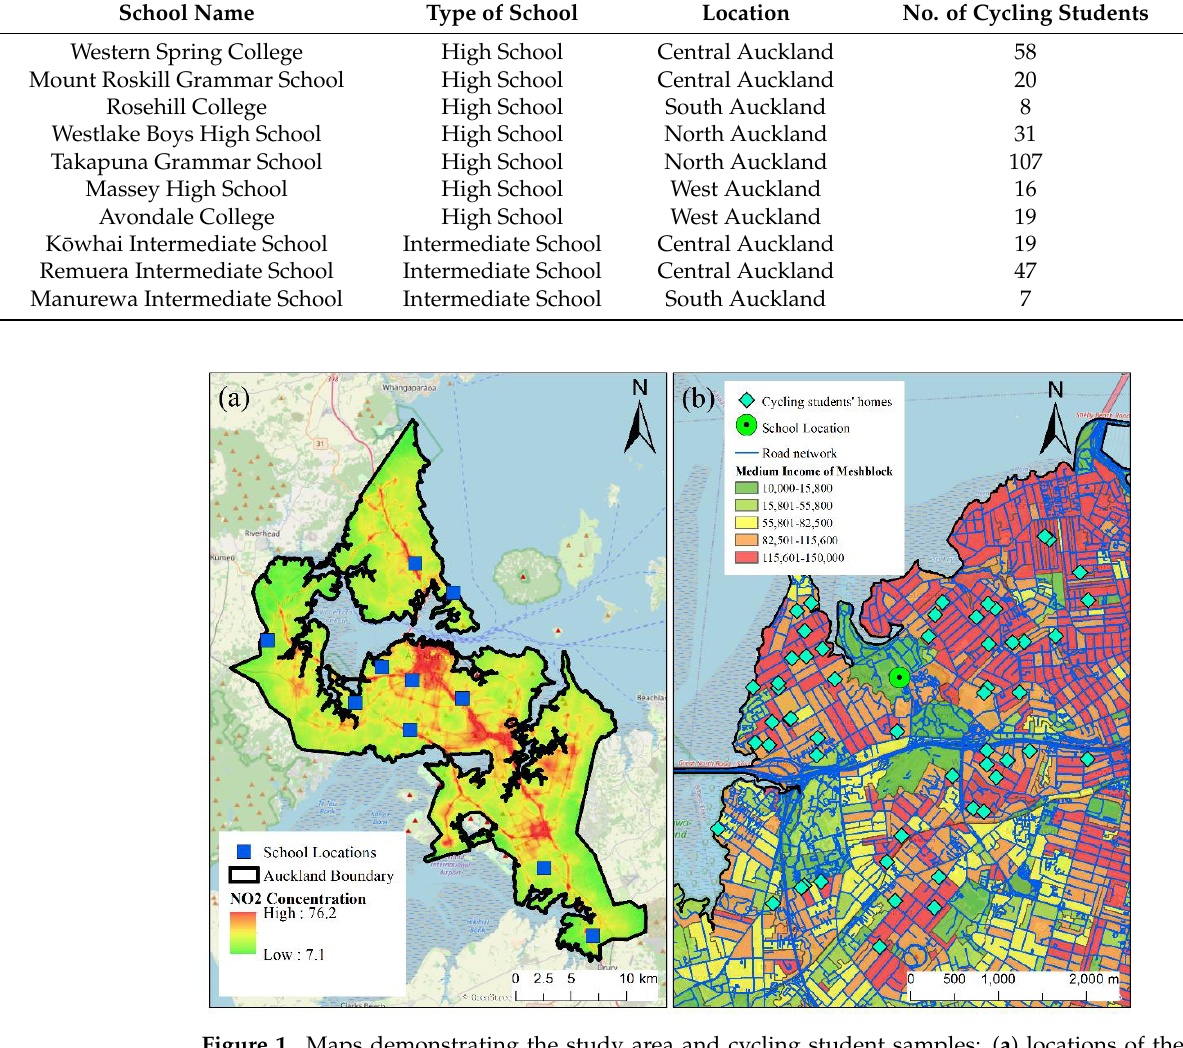
Figure 1. Maps demonstrating the study area and cycling student samples: ( a ) locations of the 10 schools involved in the study and the map of annual ambient NO 2 concentrations of Auckland; ( b ) an example showing the location of a school and the cycling students’ home addresses (Note: The legends were deliberately drawn at a rather large size to prevent the identification of the exact